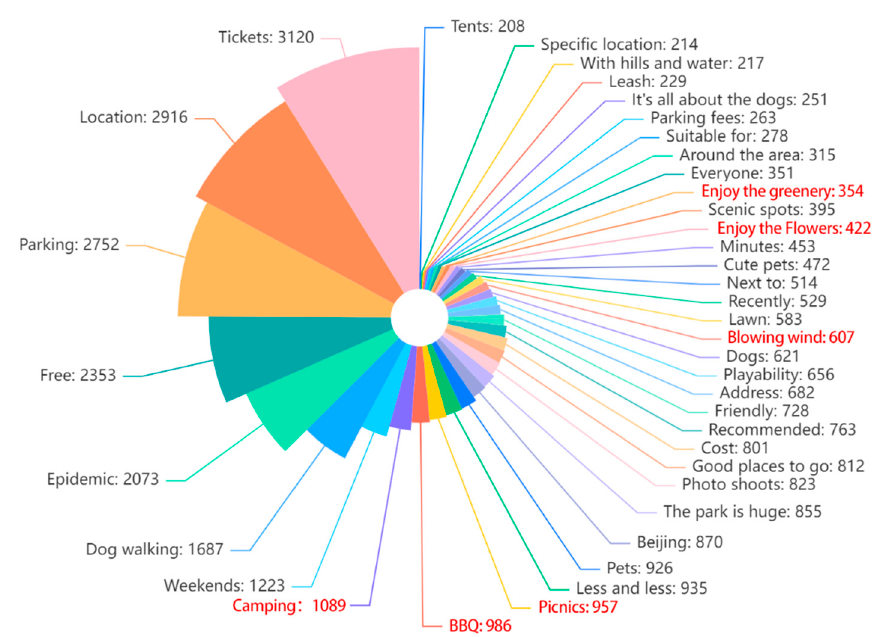
Figure 5. Word frequency rose chart (during the outbreak).